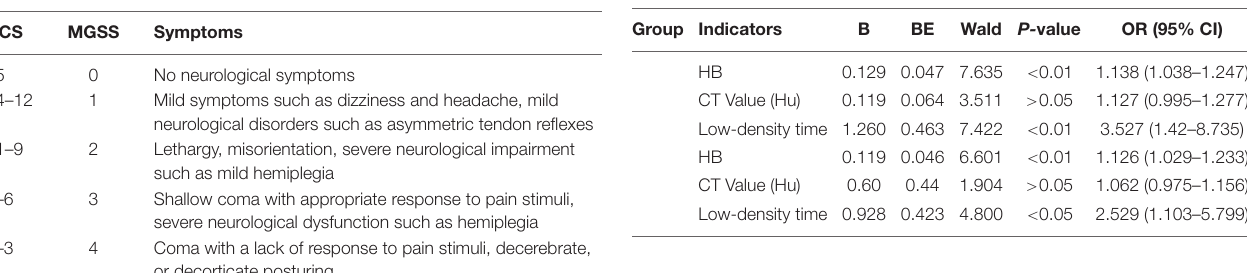
TABLE 1 | Simplified GCS and MGSS for the neurological conditions of the patients with CSDH.